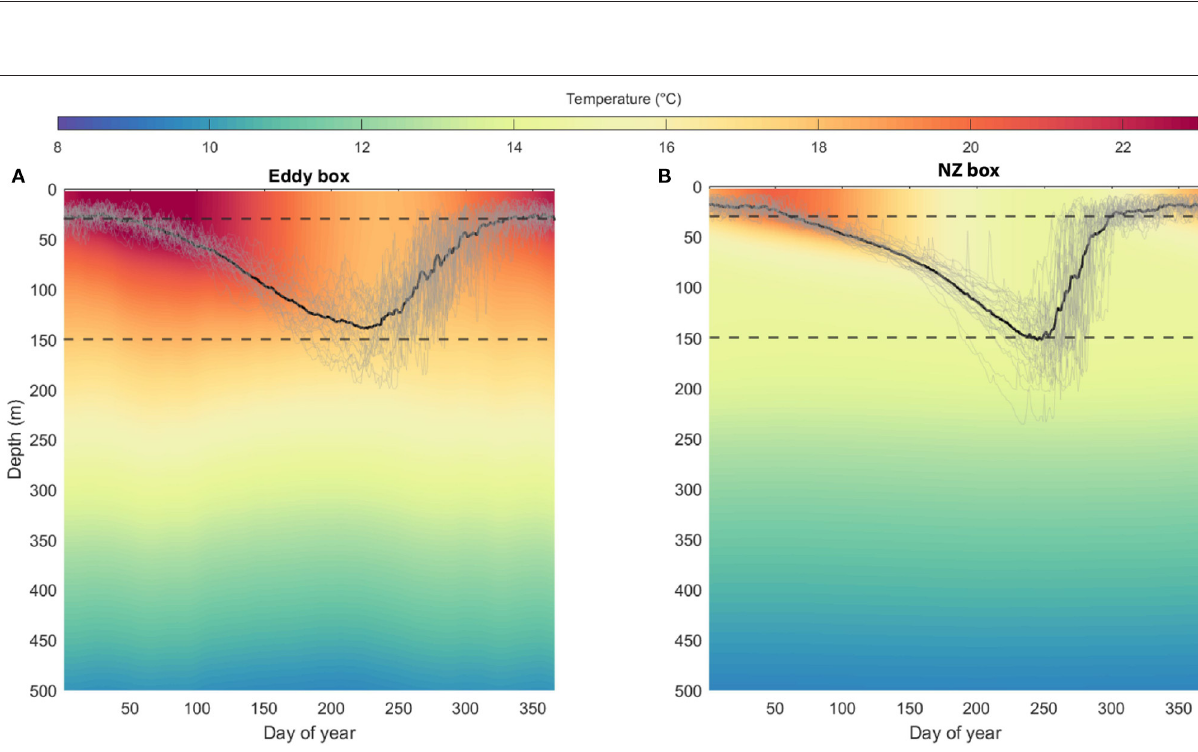
Frontiers in Climate | www.frontiersin.org